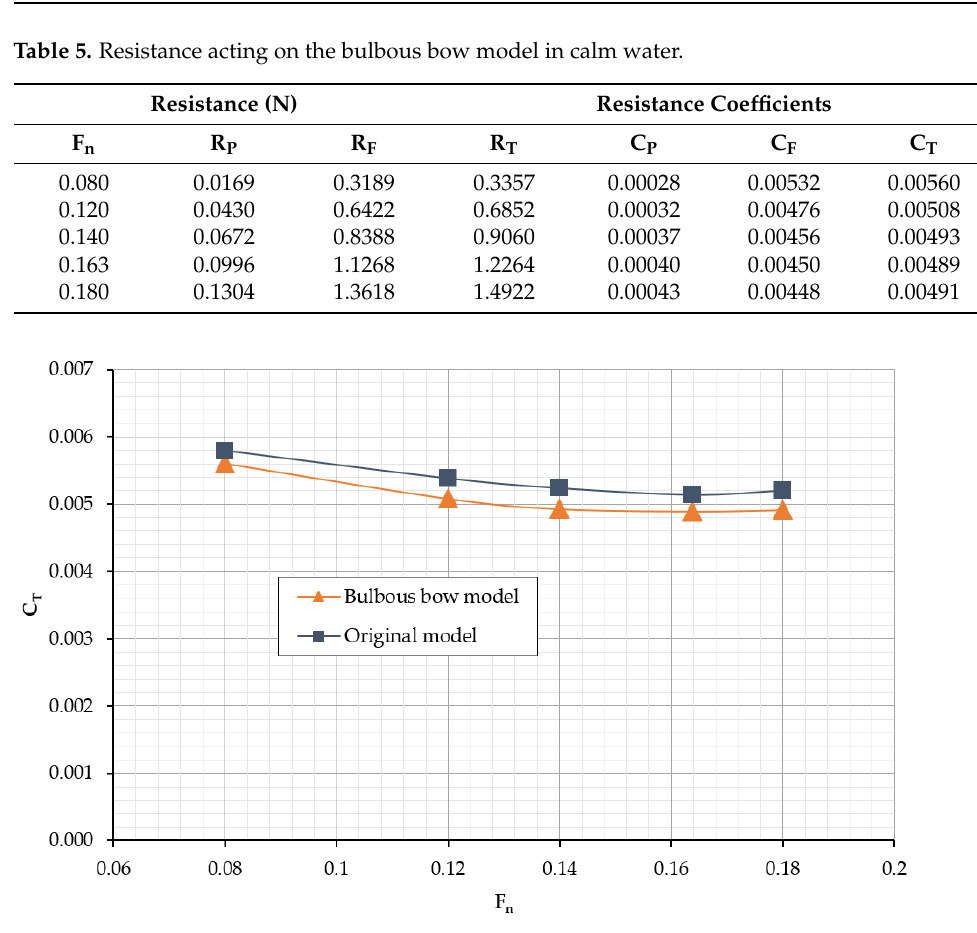
Table 4. Resistance acting on the original model in calm water.